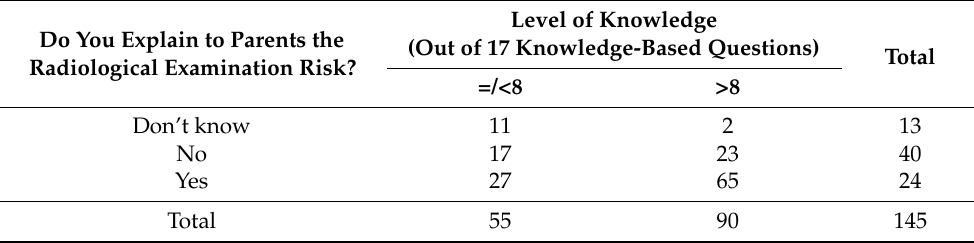
Table 8. Number of respondents who explained to parents the risks associated with radiological examination according to the level of